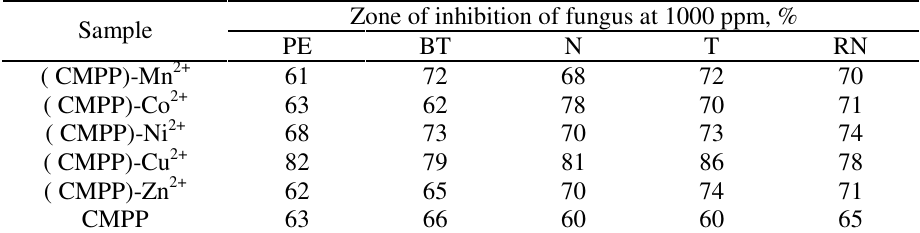
Table 3. Antifungal Activity of Ligand CMPP and its metal